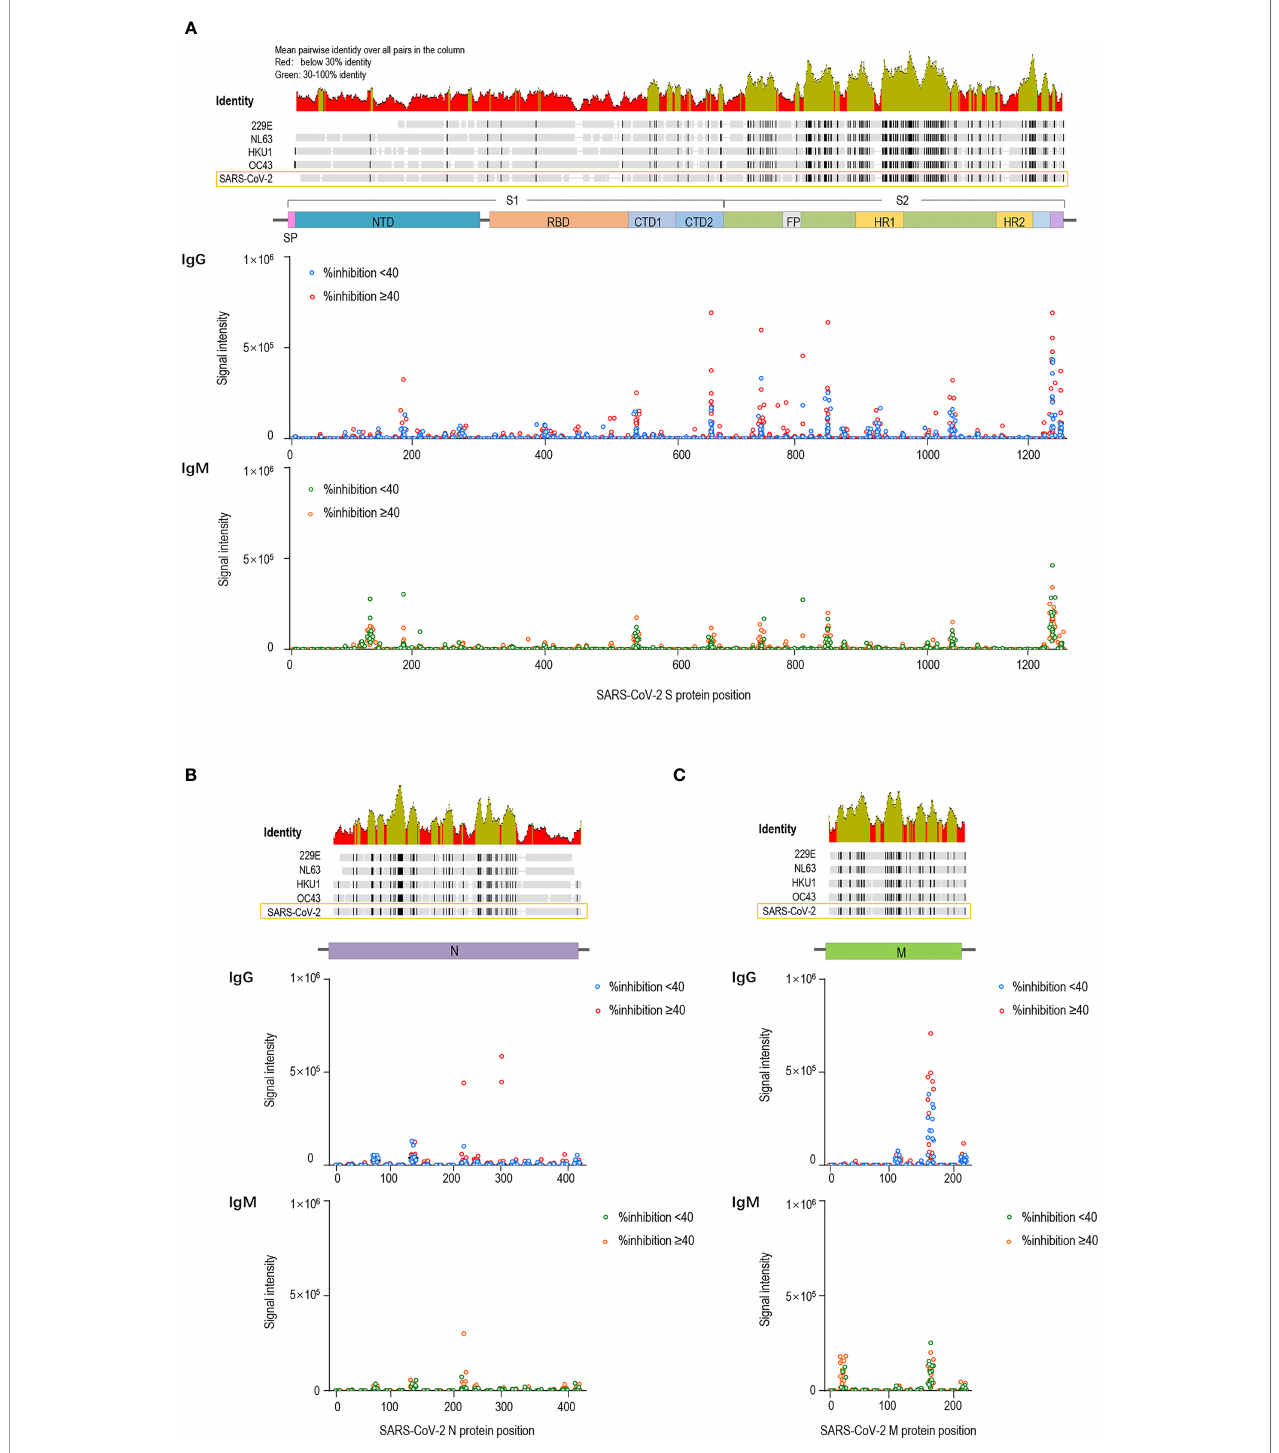
FIGURE 2 | Pre-existing cross-reactive antibodies to SARS-CoV-2 in pre-vaccination sera. The dots represent pre-existing antibody responses in pre-vaccination sera from the vaccinees who acquired %inhibition <40 and %inhibition ≥ 40 after two doses of the COVID-19 vaccine. The signal intensities of each peptide against IgG and IgM were separately mapped to the corresponding S (A) , M (B) and N (C) protein